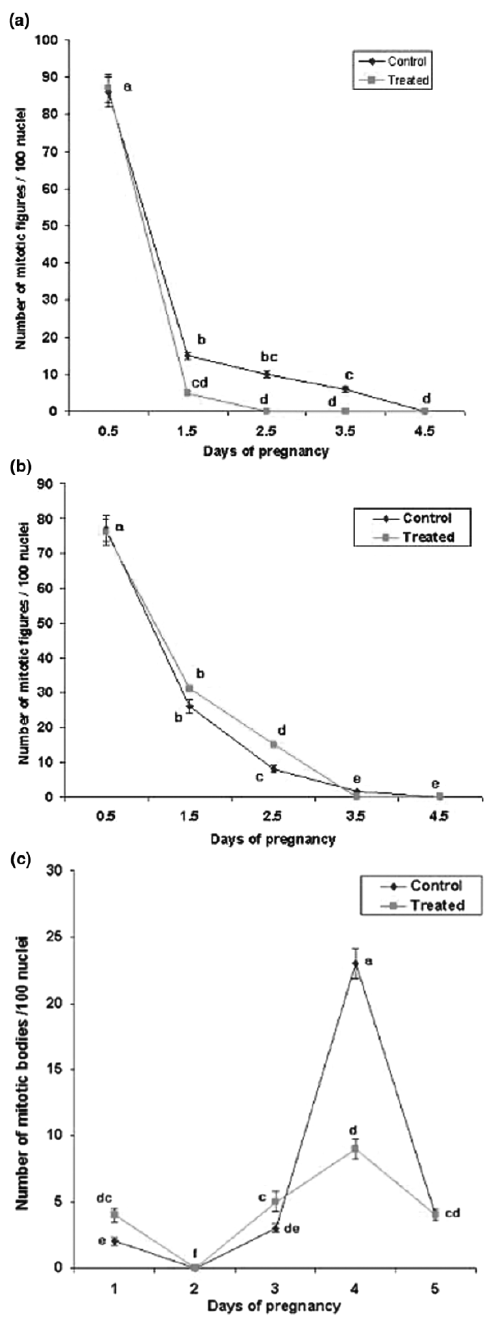
Figure 1. (a) Effect of the ‘minimum dose’ of LPS on the number of mitotic figures in luminal epithelium of uterus collected from control and LPS treated animals during different stages of preimplantation period of pregnancy. Means bearing similar superscripted alphabets do not differ from each other at P 4 0.05. (b) Effect of the ‘minimum dose’ of LPS on the number of mitotic figures in granular epithelium of uterus collected from control and LPS treated animals during different stages of preimplantation period of pregnancy. Means bearing similar superscripted alphabets do not differ from each other at P 4 0.05. (c) Effect of the ‘minimum dose’ of LPS on the number of mitotic figures in uterine stroma of uterus collected from control and LPS treated animals during different stages of preimplantation period of pregnancy. Means bearing similar superscripted alpha- bets do not differ from each other at P 4